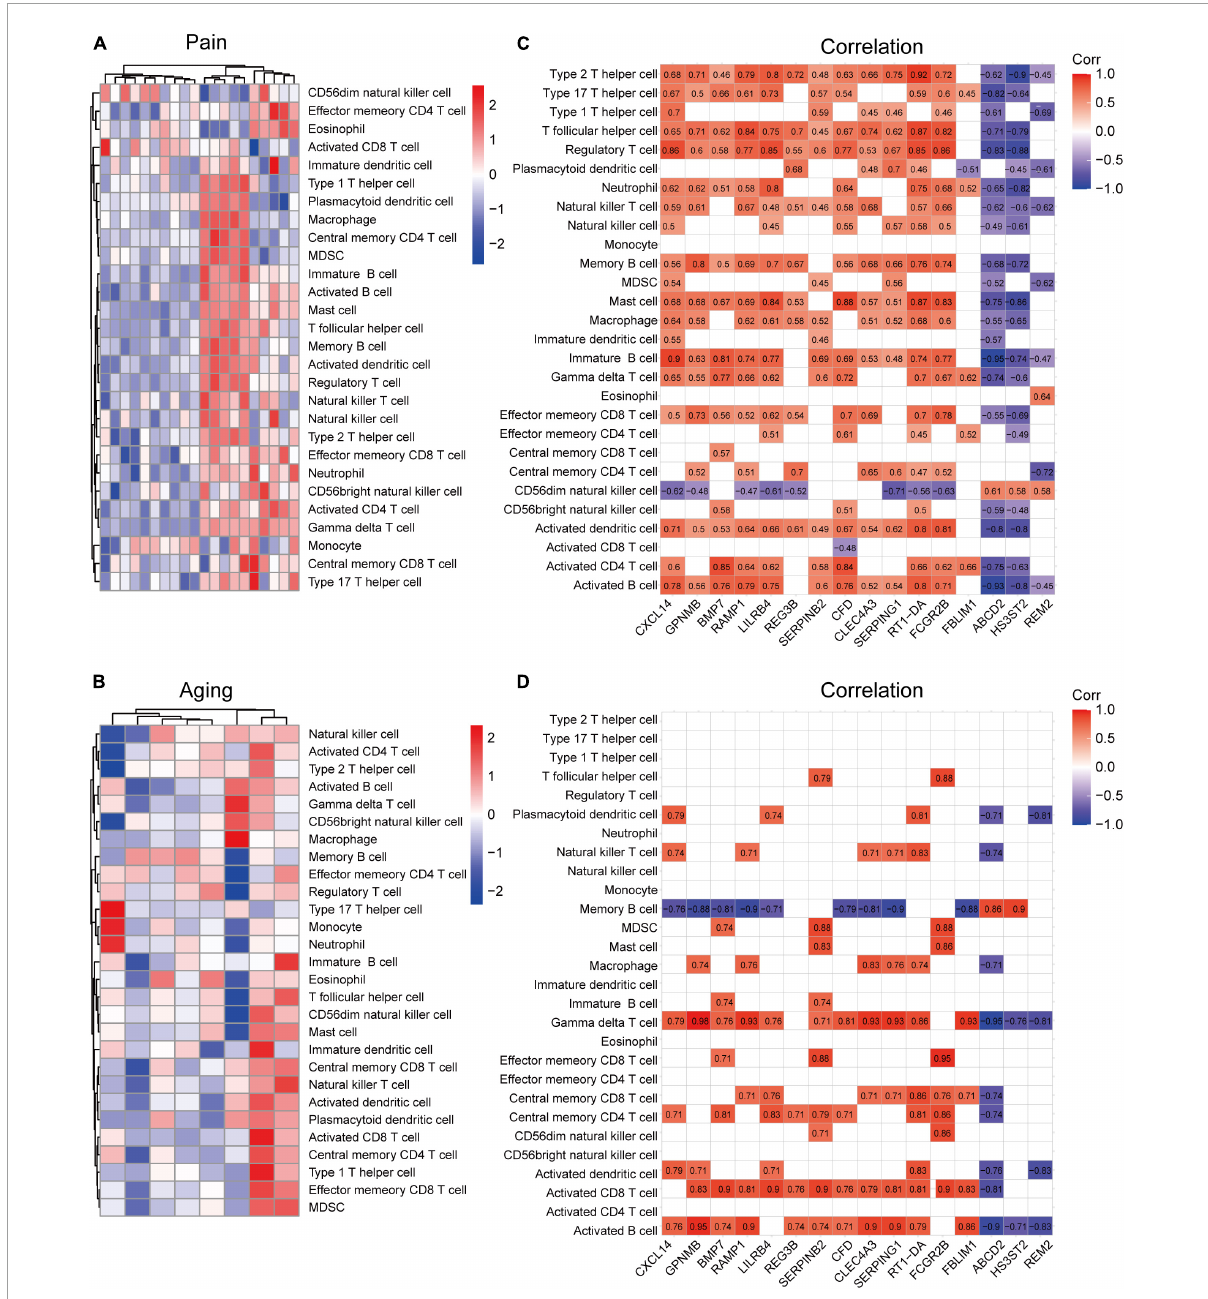
FIGURE6 Immune infiltration and correlations with co-DEGs. (A) Relative infiltration abundance of 28 immune cell subpopulations in pain. (B) Relative infiltration abundance of 28 immune cell subpopulations in aging. (C) The correlations between co-DEGs and immune cells infiltration in pain. (D) The correlations between co-DEGs and immune cells infiltration in